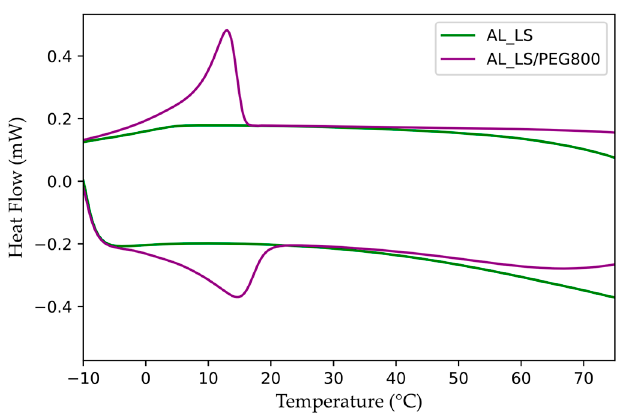
Figure 5. DSC curves recorded for aerial lime mortars with/without PEG800. Table 8. LHTES properties measured in DSC on the aerial lime mortar containing LS/PEG800 composite: Onset and Endset are initial and final temperatures of the thermal process, respectively; Tm and Tc are the peak temperatures of the melting and crystallization processes, respectively, recorded during heating/cooling stages; ∆ H is the enthalpy measured during heating/cooling stages.